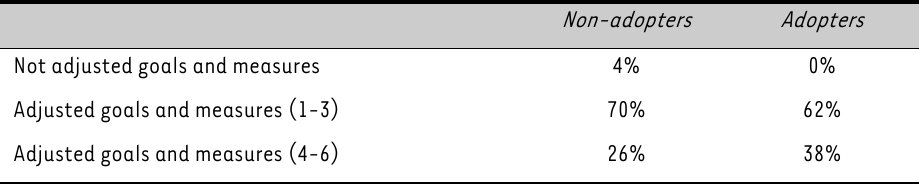
Non-adopters Adopters